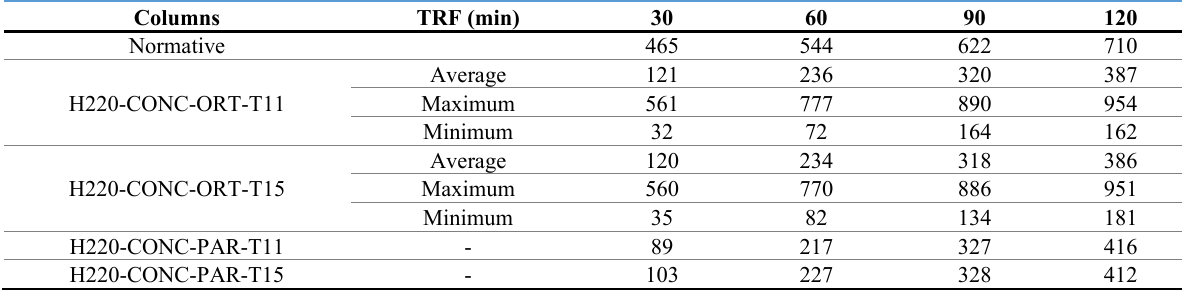
Table 6. Comparison of the temperatures obtained in the numerical model with the normative values for the steel profile web of the composite columns inserted into